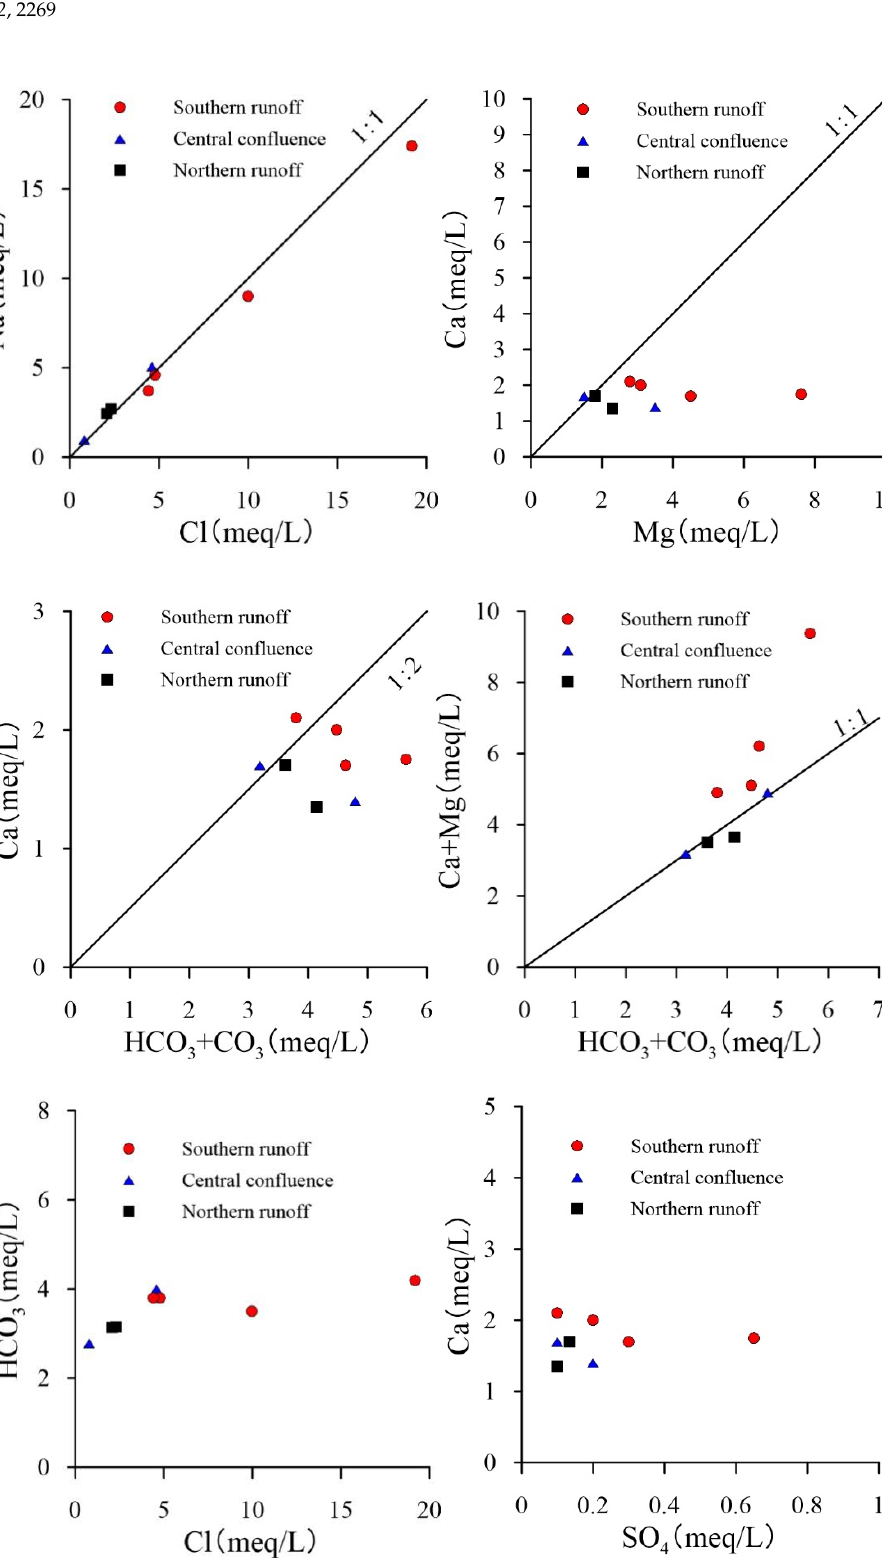
Figure 14. Bivariate diagrams of ionic concentrations in lake water.